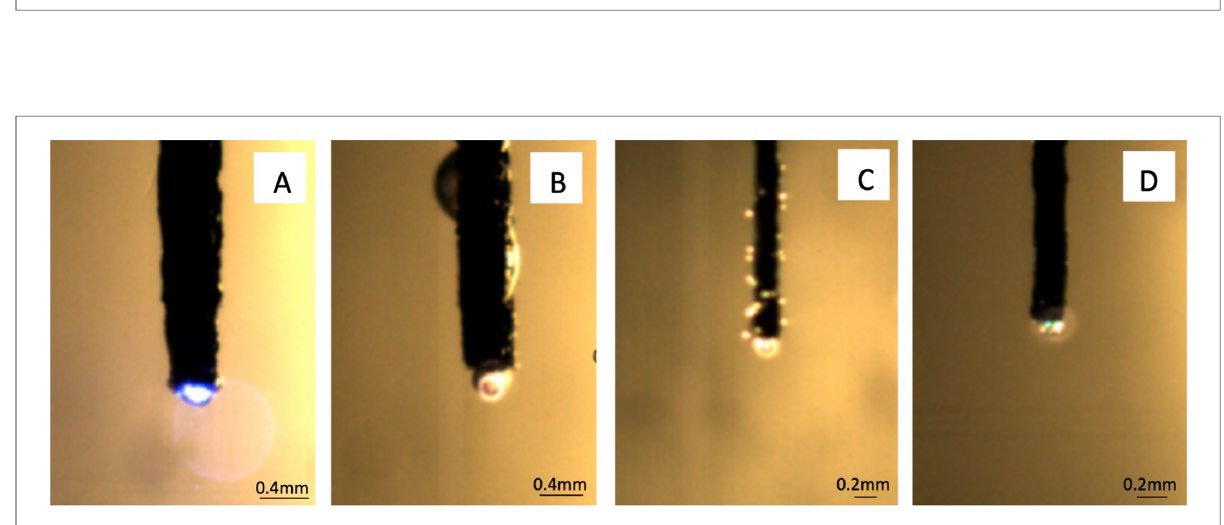
FIGURE 1 LAI with diode laser dependent on tip coating and different colors of liquids. Left to right image, absorption of 455 nm SIROLASE @ 3 W, 90%, 1 Hz avg power 2.7 W in an orange dye ( A ) and water ( B ) without coating as well as with black carbon coating in water ( C ). LAI, laser-activated irrigation.